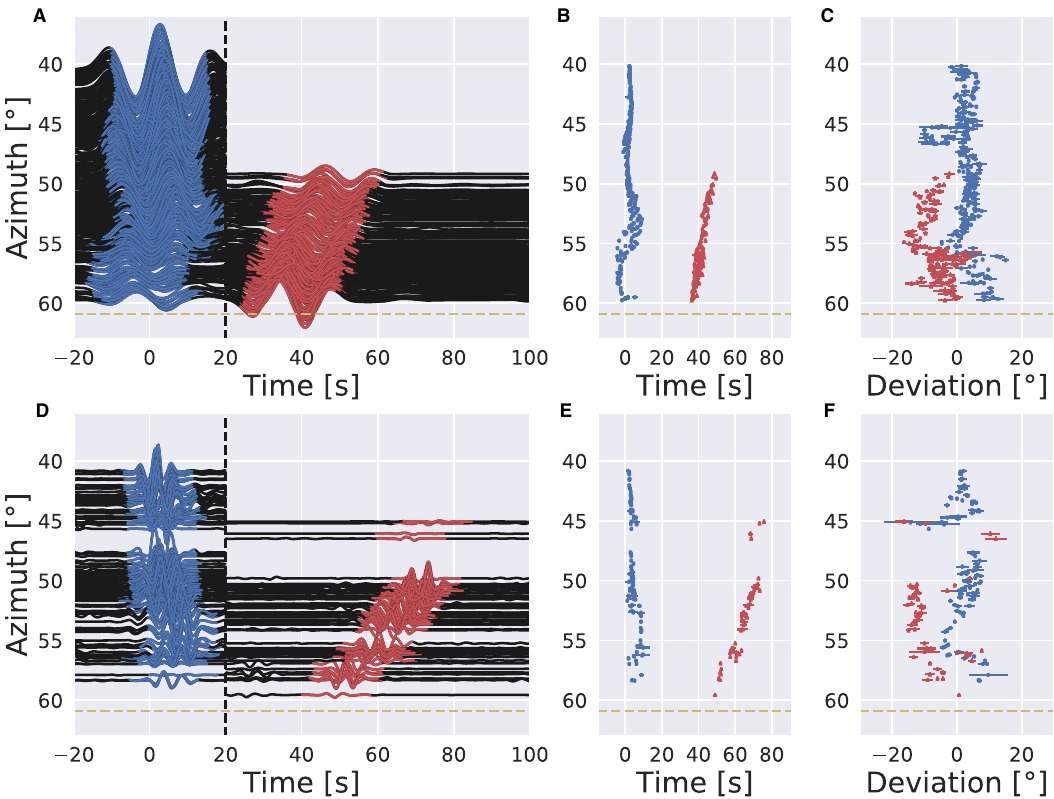
Fig. 3 Stacked data and beamforming results for the main Sdiff phases and postcursors arrivals of the 20100320 event. The time axis is aligned by the S diff travel time predicted by PREM 49 . The beamforming is performed by the predicted S diff slowness at 8.32 s/°. A Phase-weighted stacks for 10 – 20 s fi ltered data. Data stacks before 20 s (black dashed line) use the incoming direction of the main arrival (blue), post 20 s stacks use the incoming direction of postcursor energy (red). B Travel time measurements from the maxima of stacked waveform envelopes in ( A ). C Backazimuth deviations, i.e. the incoming directions used in the stacks. Error bars represent the max variance of the measurement when the value of S diff slowness is varied by ±5%. D – F as for ( A – C ) but for 3 – 6 s fi ltered data. Yellow dashed lines show the azimuth through the center of the proposed ultra-low velocity